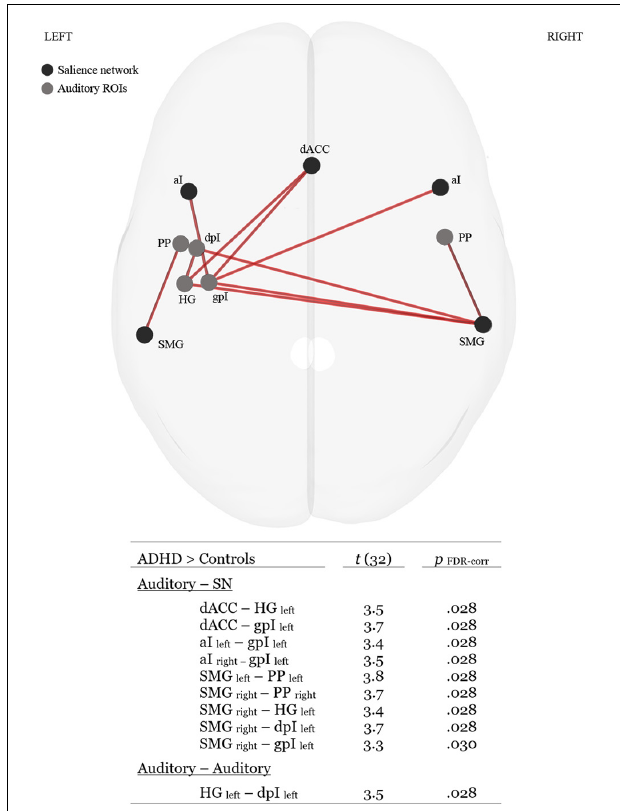
FIGURE 3 | Superior glass-brain perspective and tabulated statistics of ROI–ROI connections that were significantly stronger ( p FDR − corr < 0.05) for the ADHD group in the ATD task. HG, Heschl’s gyrus; PP, planum polare, dpI, dysgranular posterior insula; gpI, granular posterior insula; dACC, dorsal anterior cingulate cortex; aI, anterior insula; SMG, supramarginal